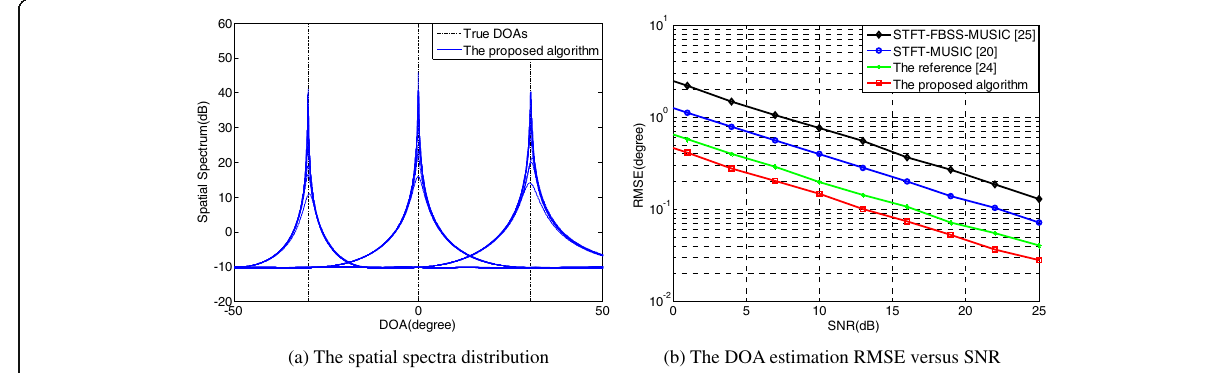
Fig. 4 The DOA estimation performance of three LFM signals, ( a ) the spatial spectrum distribution, ( b ) the RMSE of DOA estimation versus